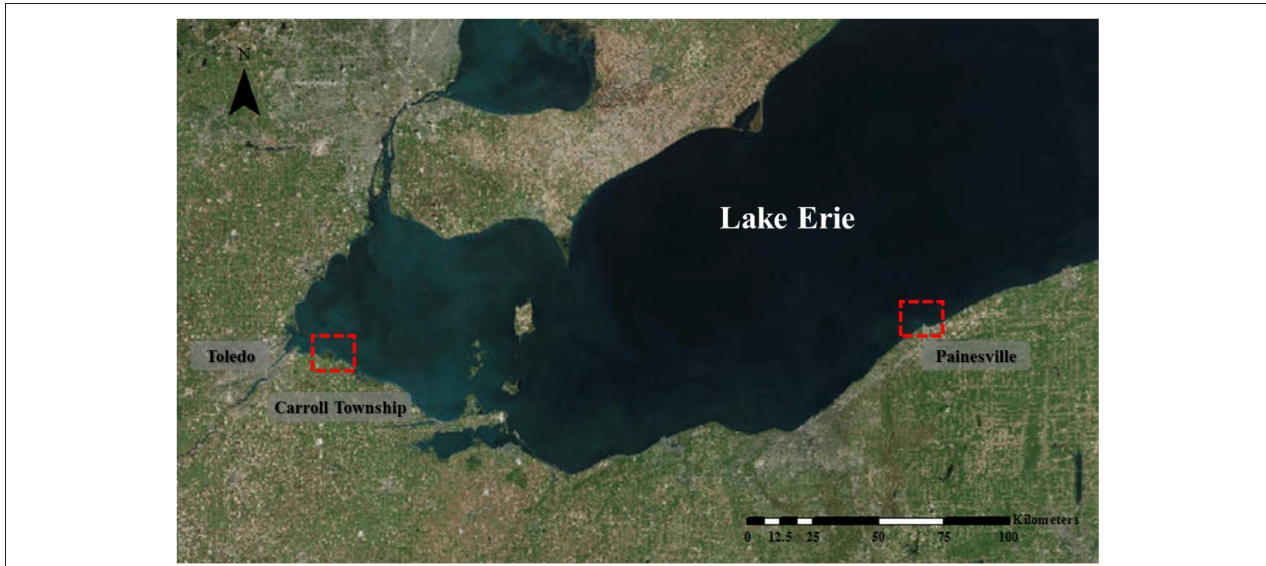
FIGURE 1 | Map showing the intake locations of the Toledo and Painesville water